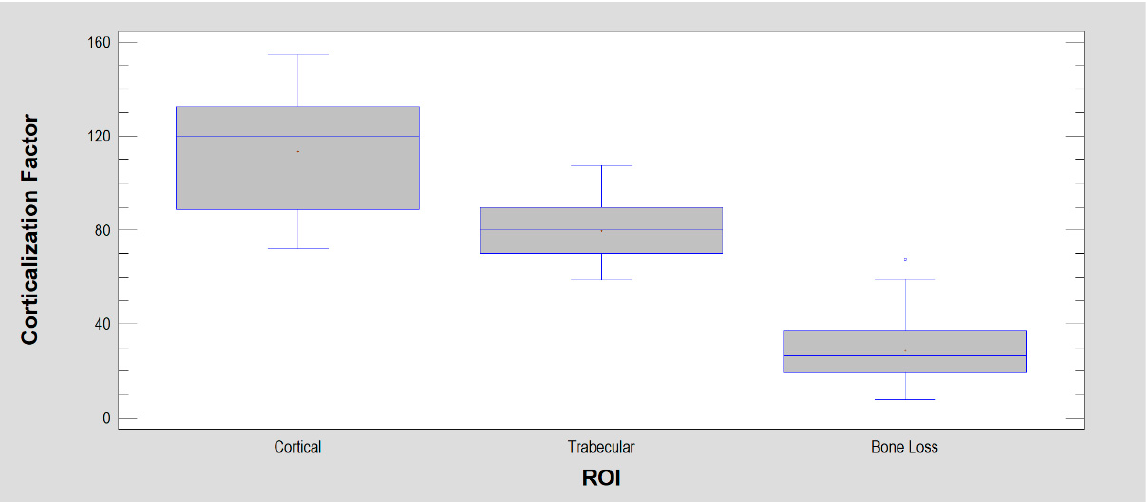
Figure 7. Corticalization Factor (CF). It has statistical features similar to BI, but it is most strongly expressed in cortical sites, weaker in trabecular bone and weakest in soft tissues. The relationships of the corticalization index with the bone index and corticalization factor are shown in Figure 8 below.